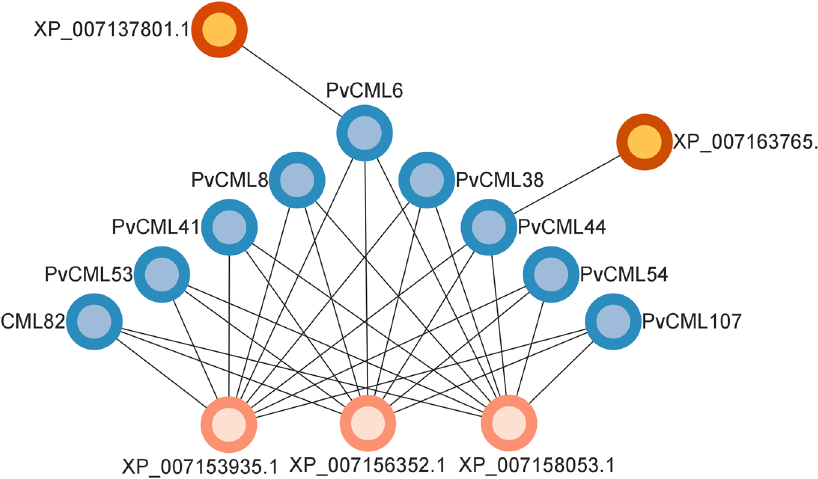
Figure 8. Interaction network of the nine PvCML